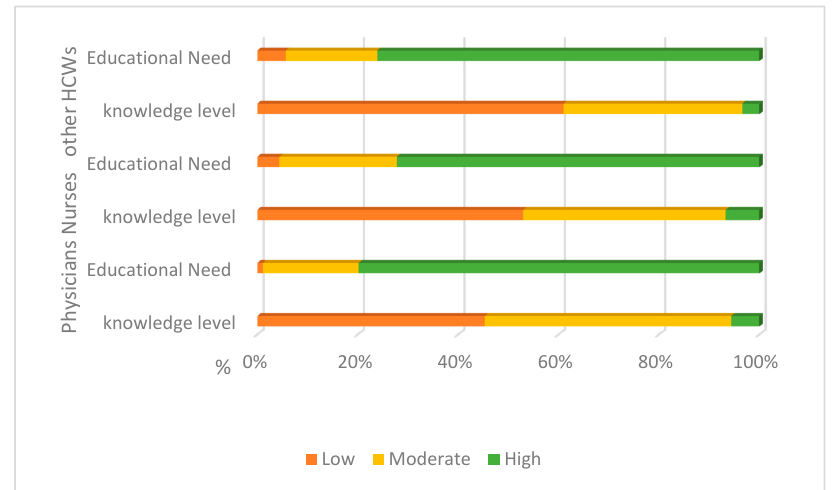
Figure 3. Perception of the HCWs about the level of their knowledge and the needs of educational courses about MERS-CoV and other emerging infectious diseases.